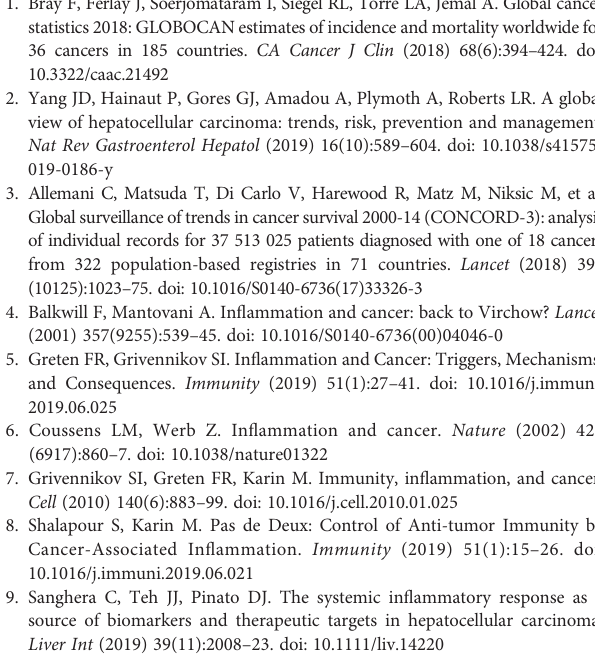
Supplementary Figure 3 | Each prognostic gene expression between HCC tissues and adjacent non-tumorous tissues in TCGA. Supplementary Figure 4 | Each prognostic gene expression in different groups divided by clinical characteristics. (A) Age. (B) Gender. (C) Tumor grade. (D) Tumor stage. Supplementary Figure 5 | The expression of prognostic genes in different immune in fi ltrate subtypes. Supplementary Figure 6 | The relationship of prognostic gene expression with RNAss, DNAss, Stromal Score and Immune Score. Supplementary Figure 7 | Signi fi cant GO terms associated with high-risk score group. Supplementary Figure 8 | Signi fi cant KEGG pathways associated with high-risk score group. Supplementary Figure 9 | Signi fi cant Hallmarks gene sets associated with high- risk score